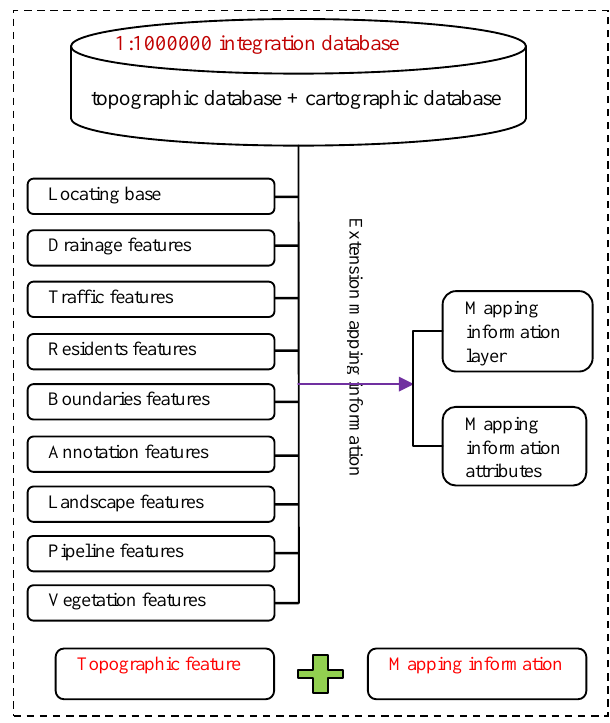
Figure 3. Structure and content of integration